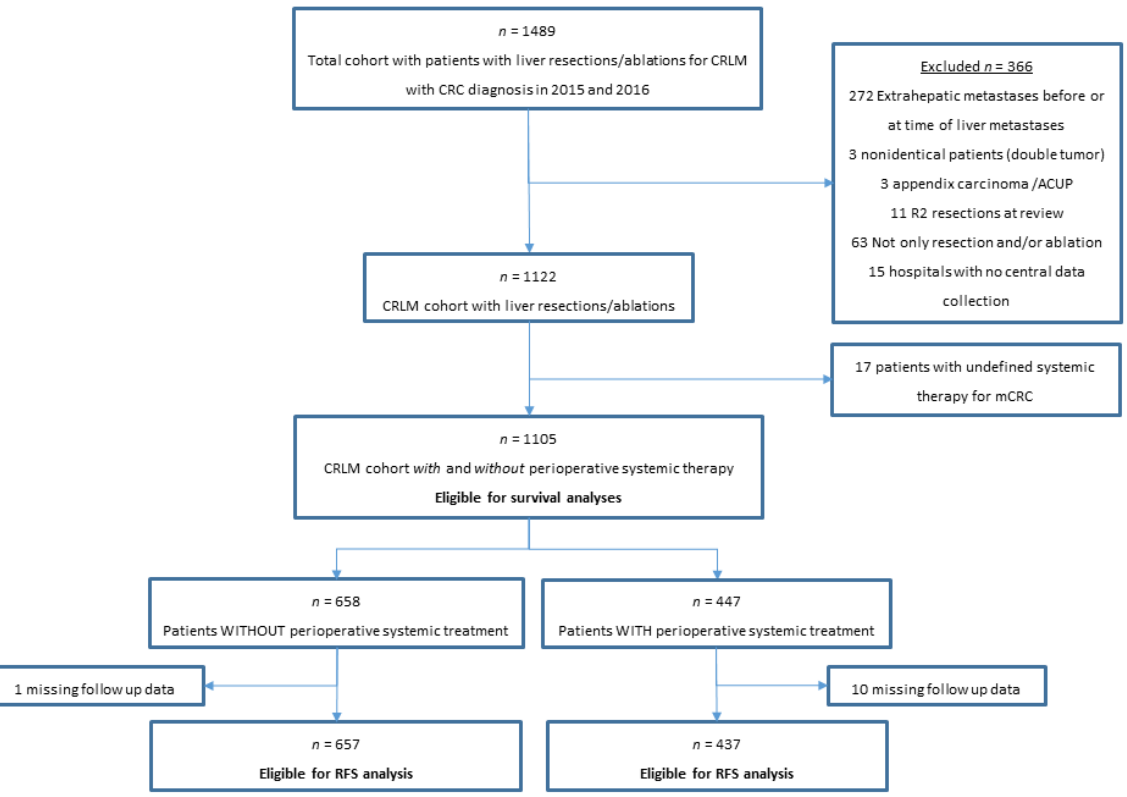
Figure 1. Flowchart of population-based NCR patients with local liver treatment for CRLM included in the study. Abbreviations: ACUP, adenocarcinoma with unknown primary; CRLM, colorectal liver metastases; mCRC, metastatic colorectal cancer; RFS, recurrence-free survival.